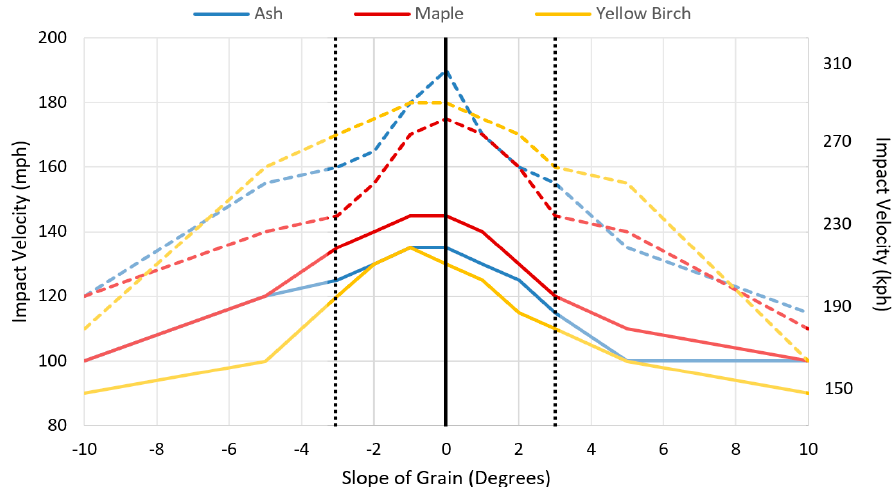
Figure 12. Single-piece (solid lines)/multi-piece failure (dashed lines) threshold for 2 in. (5.1 cm) impact models.